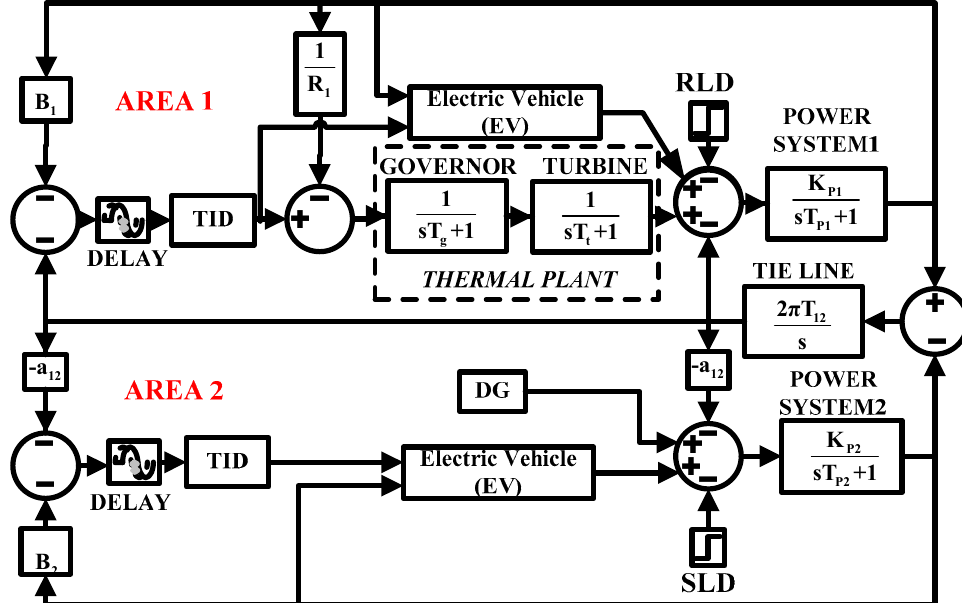
Figure 1. First test system undertaken for investigation.